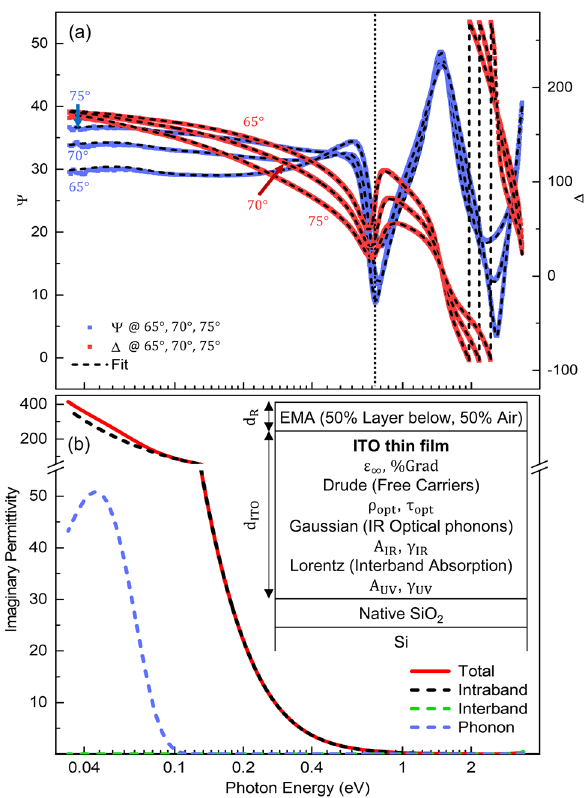
Figure 1. Ellipsometric measurement and as-fit permittivity of the seed ITO thin film. ( a ) Measured �( E ) (blue squares) and �( E ) (red squares) at 65 ◦ , 70 ◦ , and 70 ◦ for the higher resistivity seed ITO thin film alongside their corresponding fits (dashed black lines). ( b ) The fitted imaginary permittivity of the seed ITO thin film (solid red line), where the individual components of the imaginary permittivity for the free carriers, interband transitions and phonon mode are represented by the dashed black, blue and green dashed lines, respectively. A logarithmic scale in the x-axis is used in ( a,b ) to exaggerate the IR spectral region. The vertical dotted black line in ( a ) presents the cut-off between the spectral ranges of the two IR and NIR-VIS ellipsometers. The inset in ( b ) presents a schematic of the geometric and parametrised optoelectronic